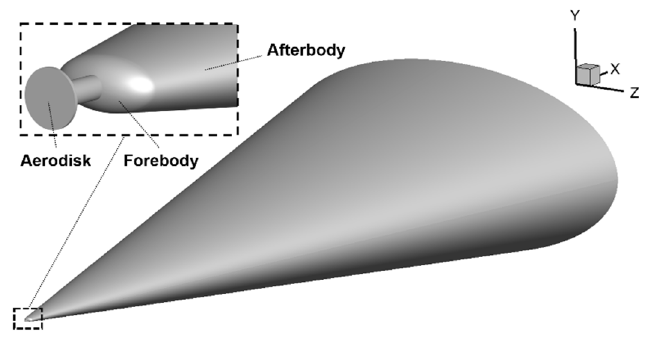
( b ) Figure 1. Comparison of γ and TSP distributions. ( a ) γ distribution, numerical simulation, ( b ) TSP image, wind tunnel experiment result.